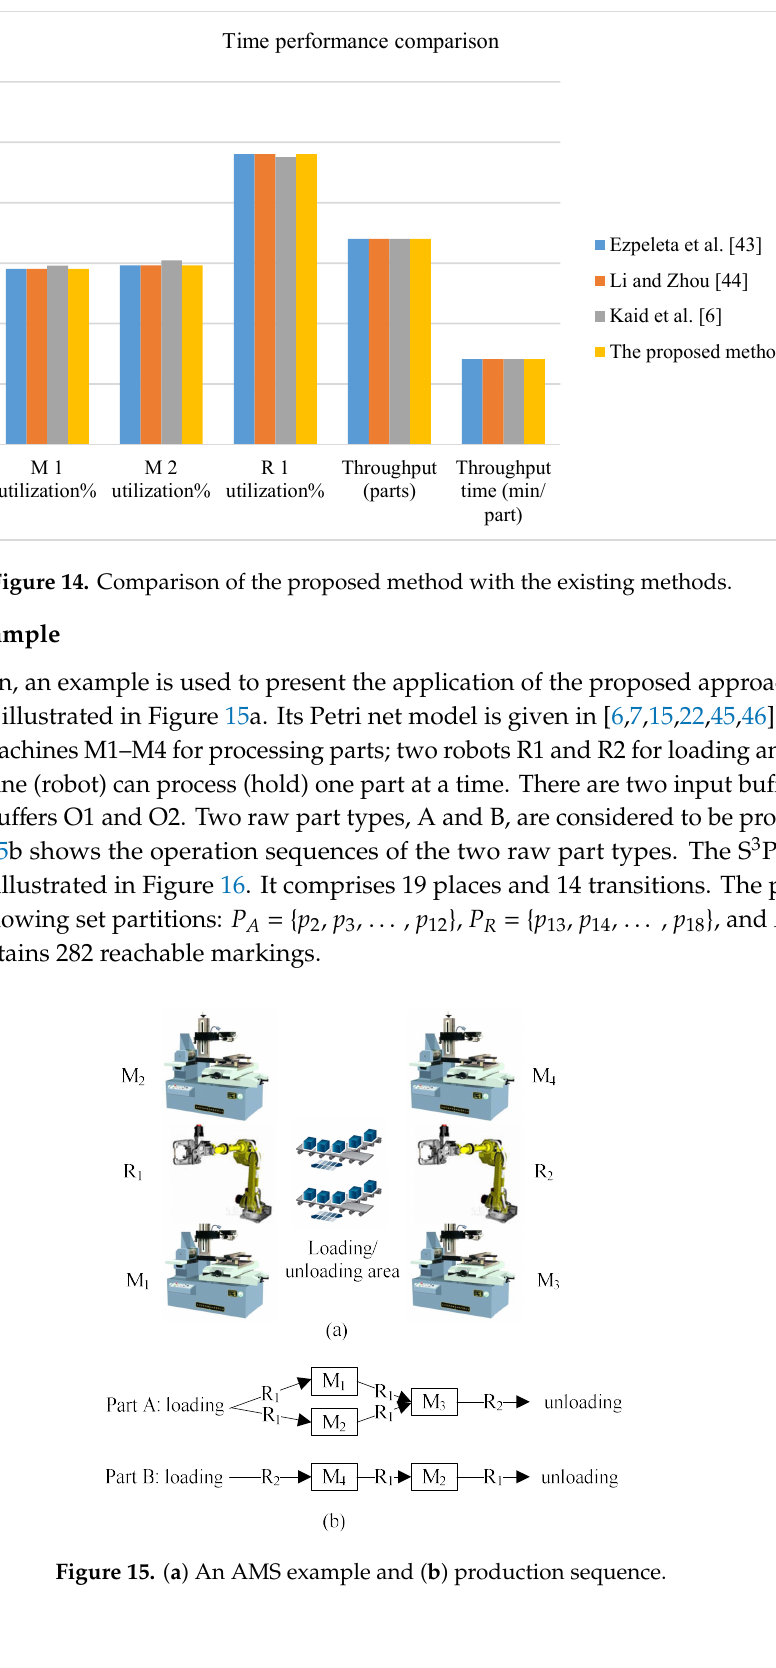
Figure 15. ( a ) An AMS example and ( b ) production sequence.